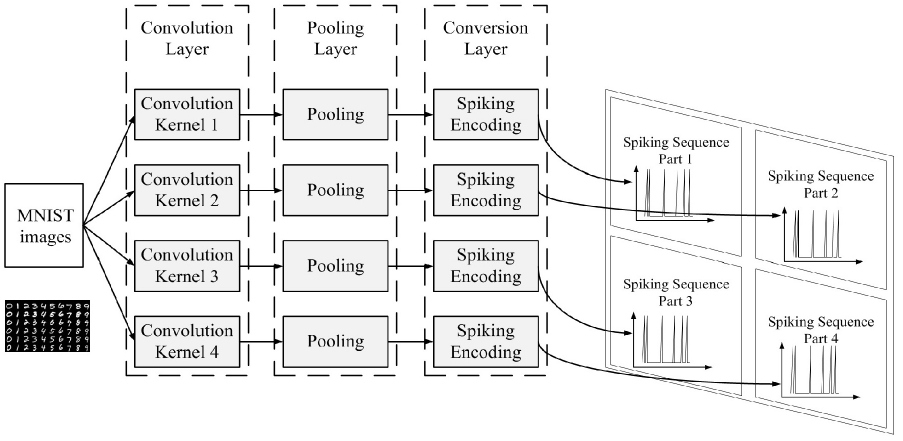
Figure 3. The flow of the Spiking Encoding Module